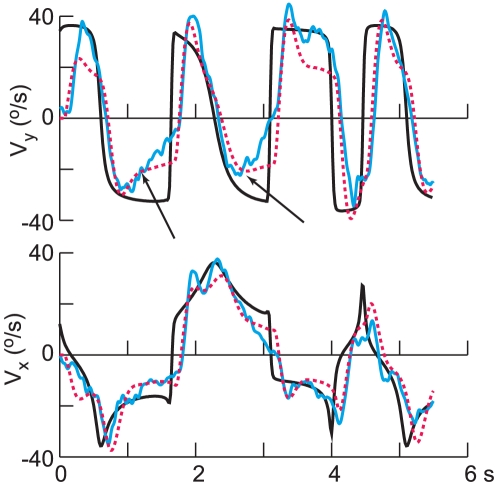
Instance in which the model gave a poor fit to the data.Two intervals in which there was a discrepancy between the model's predictions and the experimental data for the vertical velocity component (vy) are indicated by the arrows. In each instance, eye velocity decayed to zero, whereas the target velocity remained large and negative. Both instances correspond to times when the target approached the lower border (see Path 1 in Fig. 1).